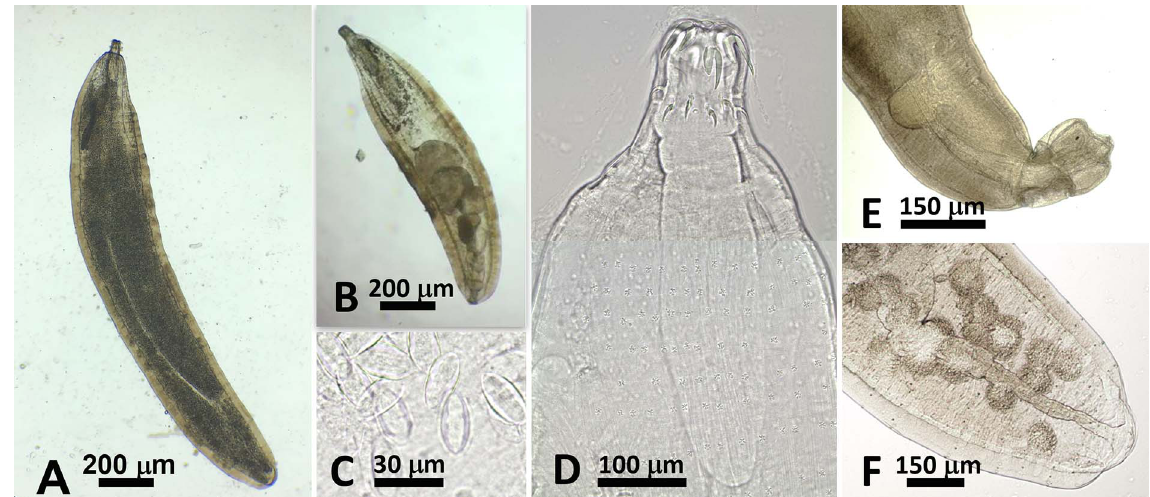
Figure 2. Acanthocephalan Acanthogyrus ( Acanthosentis ) cf. tilapiae from Coptodon guineensis at Sebkha Imlili. Fresh preparations. A. Female worm (gravid). B. Male worm. C. Ellipsoid eggs in gravid female. D. Proboscis and anterior trunk (montage) of male worm. Note strong anterior hooks and abruptly smaller middle and posterior hooks as well as regular rows of spines that were lost and leave rosette marks on tegument. E. Posterior end of male worm showing terminal genital opening and everted copulatory bursa. F. Posterior end of female showing terminal genital opening.